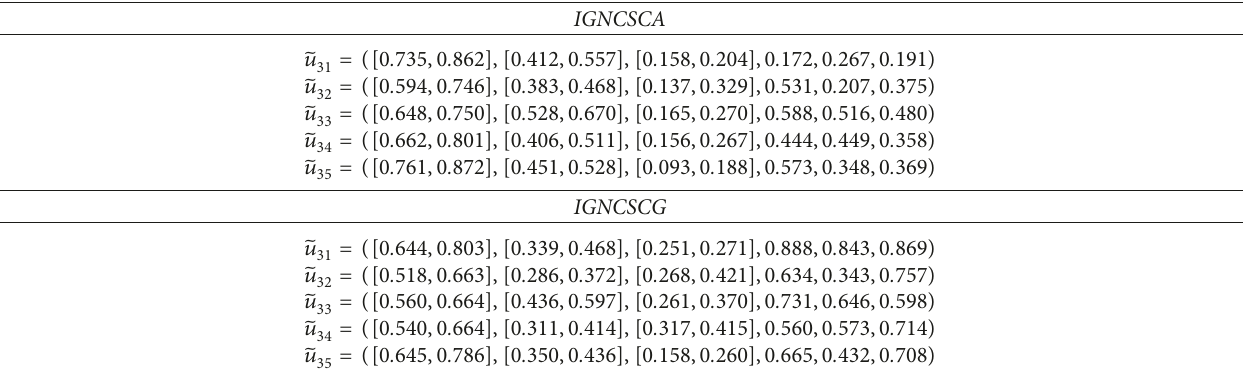
Calculate assessment of each alternative and rank Figure 4: Flowchart. Table 6: The aggregated neutrosophic cubic value data by IGNCSCA and IGNCSCG.